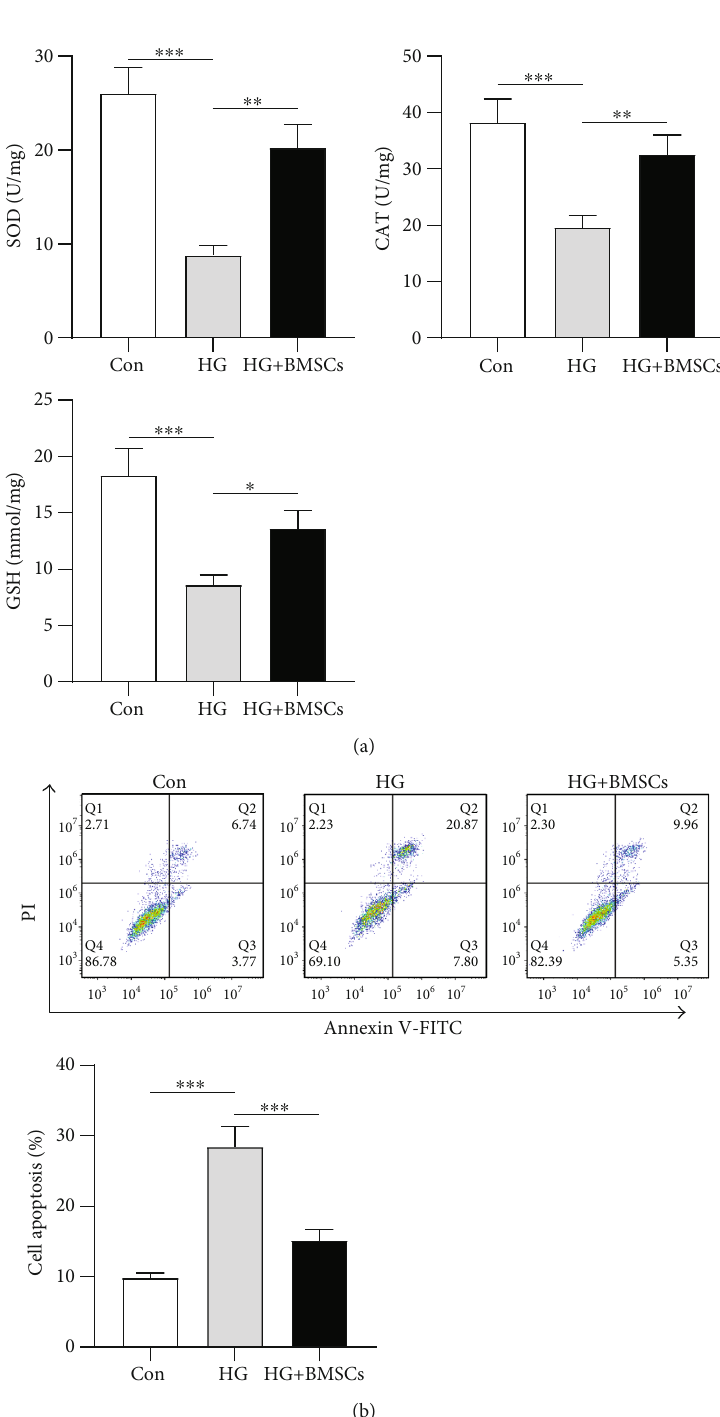
Figure 3: BMSCs alleviate oxidative stress injury and apoptosis in HG-treated HRMECs. (a) ELISA was conducted to detect CAT and SOD activities and GSH content in HG-treated HRMECs after BMSC treatment. (b) Flow cytometry analysis was performed to probe HG-treated HRMEC apoptosis after coculture with BMSCs. ∗∗ p < 0 : 01 and ∗∗∗ p < 0 : 001